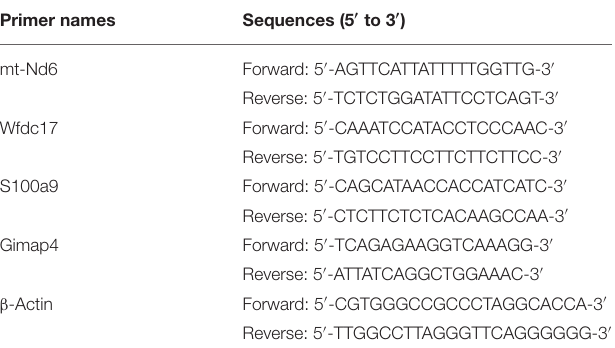
TABLE 1 | The qRT-PCR primer sequences used in the